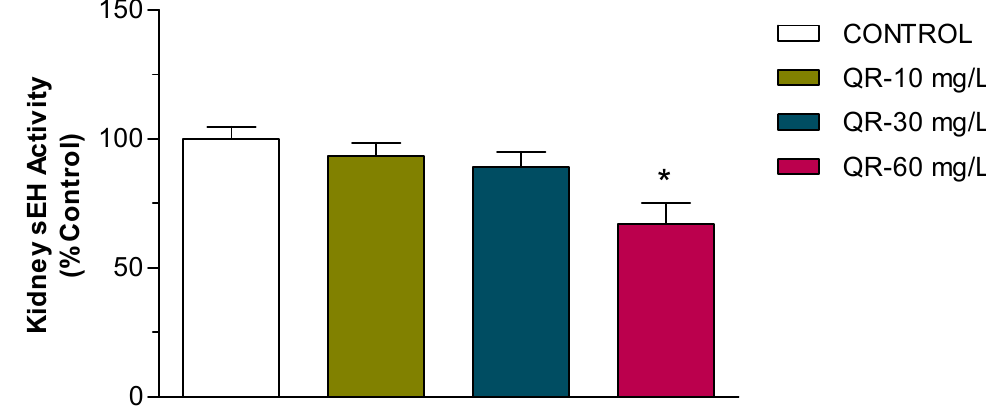
Figure 5. Effect of QR on the activity of kidney soluble epoxide hydrolase (sEH). Mean sEH activity from rat kidney cytosols ( n = 8/group) treated for 7 weeks with QR in drinking water at different concentrations, expressed as the percentage of the control group. All groups were compared using one ‐ way ANOVA followed by multiple comparisons. * Significant difference from control with p < 0.05. To examine the impact of changing the activity of CYP4A and sEH on the overall changes in blood pressure caused by different QR doses, we determined the correlation between these